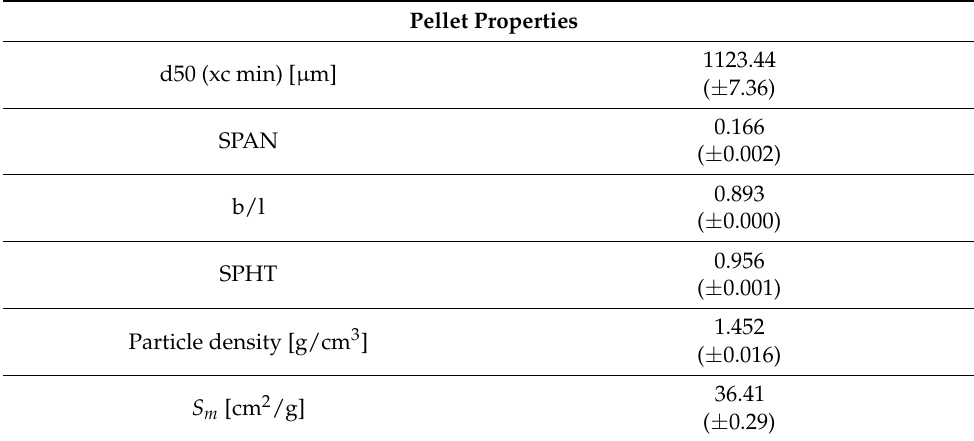
Table 1. Pellet properties of Cellets